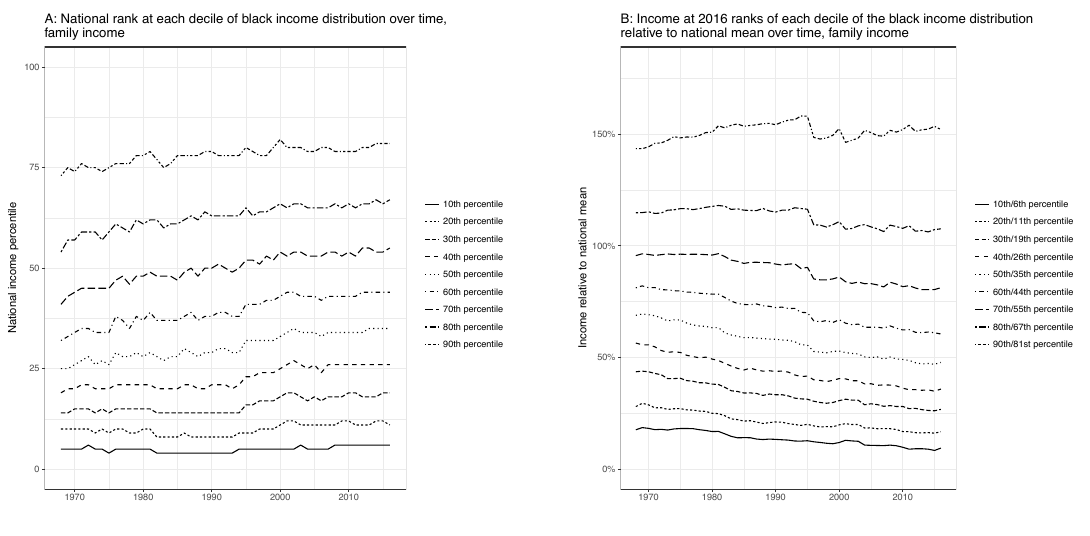
Figure 5: Trends in rank and incomes at each rank for each decile of the African American income distribution. Quantifying the Effect of the Changing